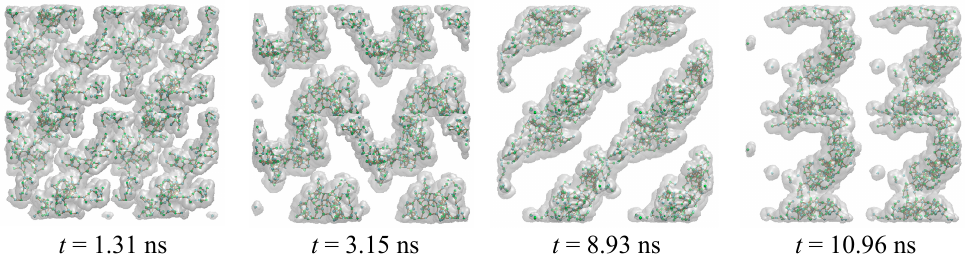
Figure 4. D simulations snapshots in the aqueous solution with CaCO 3 concentration of 1.44 mol/L at 360 K. In order to observe the phenomenon of phase separation clearly, the snapshots were extended a periodic boundary in the x and y directions, respectively. The green, cyan, and gray colors represent Ca 2+ , CO 32 − , and the hydration shell, respectively.